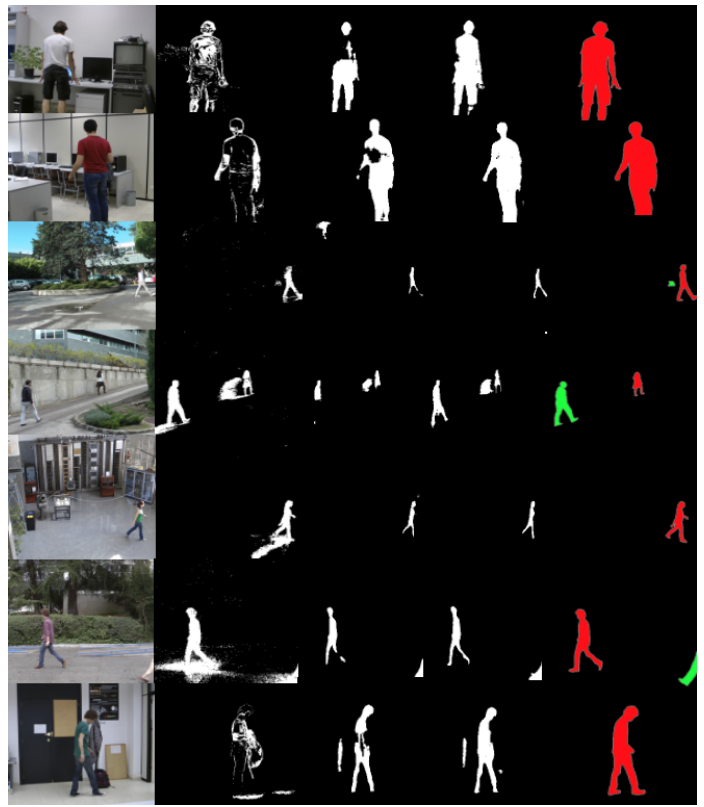
Figure 7. Examples for the evaluation of the mask through the mask refinement method with LASIESTA database. First column shows original images. Second column, input rough mask provided by [11]. Third row, results of the network using the semantic segmentation network without adversarial loss, as in [21]. Forth column shows the results of this paper. Last column shows the ground truth